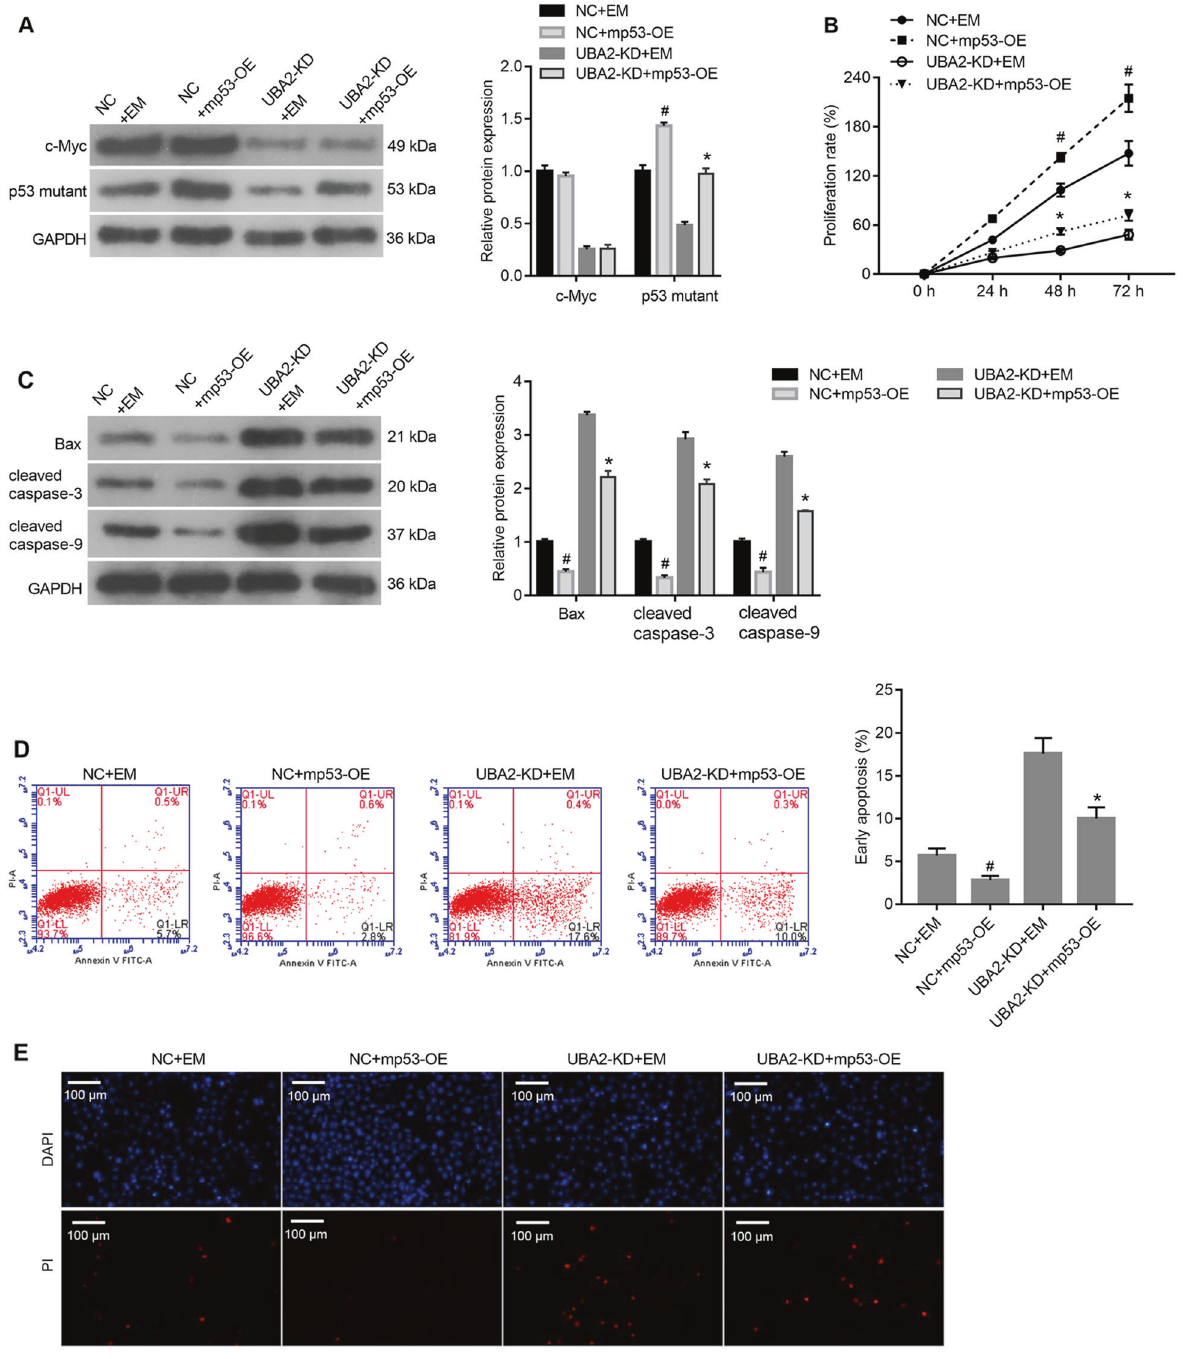
Fig. 5 Alleviation of the effects of UBA2 knockdown on 786-O cell proliferation and apoptosis via overexpression of the p53 mutant. A Expression levels of the p53 mutant and c-Myc in cells transfected with mp53-overexpressing and control plasmids. B Proliferation rates of cells in ( A ). C Expression levels of proapoptotic proteins in cells in ( A ). D Proportions of apoptotic cells in the populations of cells in ( A ). E PI staining of cells in ( A ). # p < 0.05 NC + mp53-OE vs. NC + EM; * p < 0.05 UBA2-KD + mp53-OE vs. UBA2-KD + EM. DAPI 4 ′ ,6-diamidino-2- phenylindole, PI propidium iodide, OE overexpression, KD knockdown, NC negative control, mp53 p53 mutant, EM empty